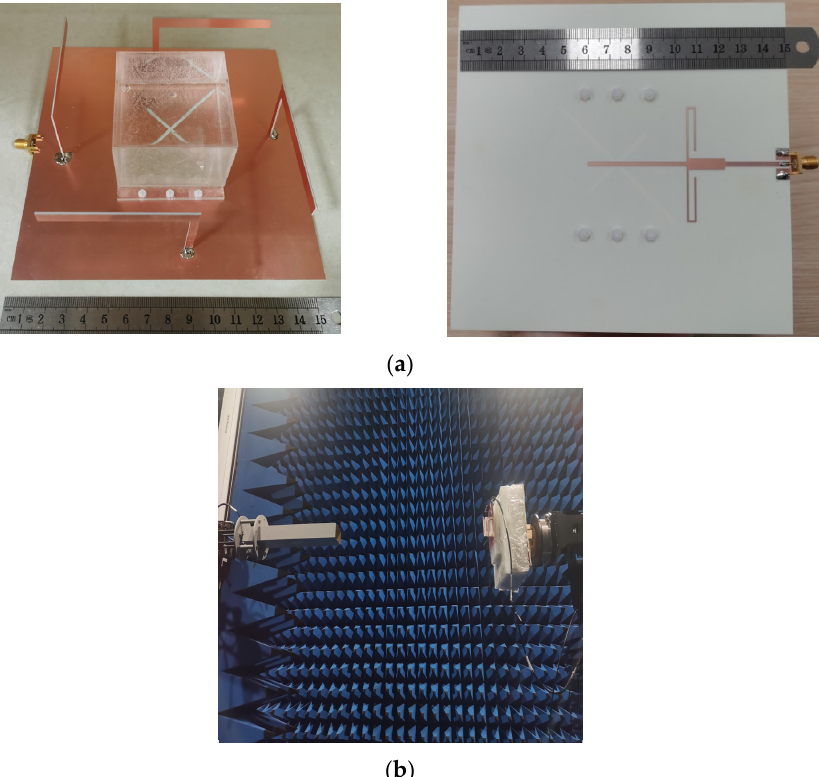
Figure 6. The proposed antenna. ( a ) Fabricated prototype. ( b ) Measured